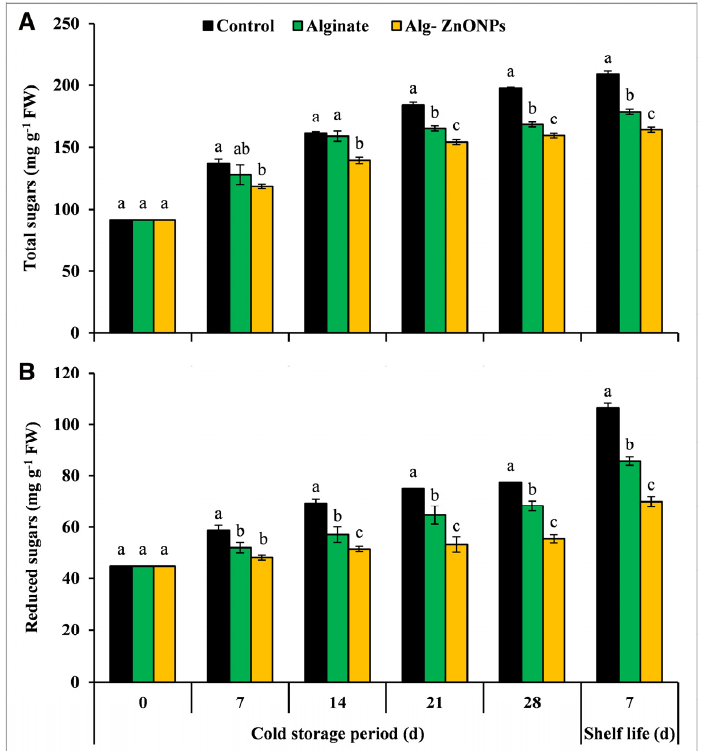
Figure 13. Effect of Alg–ZnO NPs on total sugars ( A ) and reducing sugars ( B ) of “Kiett” mango fruits during cold storage and shelf life; vertical bars represent the standard error (SE). Bars marked with the same letter in each sampling date are not significantly different with 95% confidence according to Duncan’s multiple range